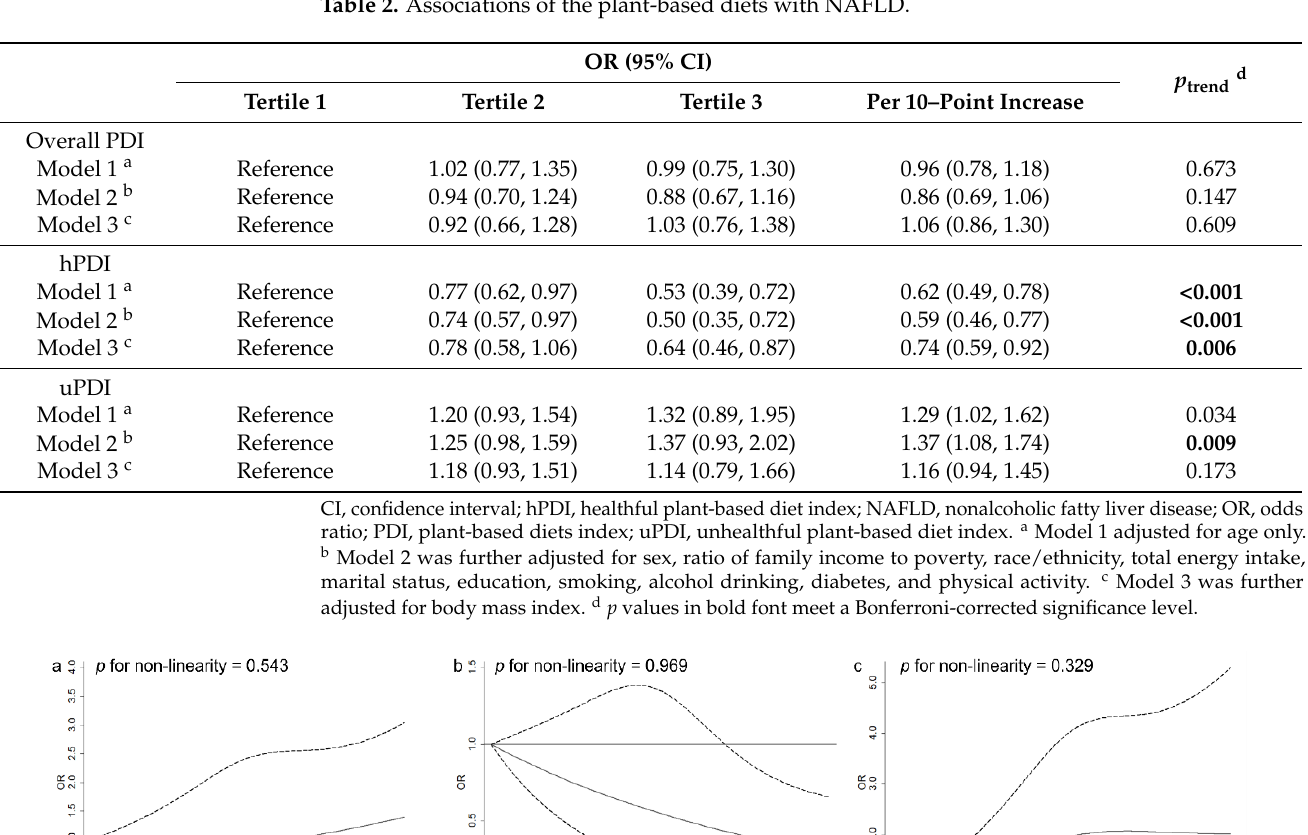
Table 2. Associations of the plant-based diets with NAFLD.